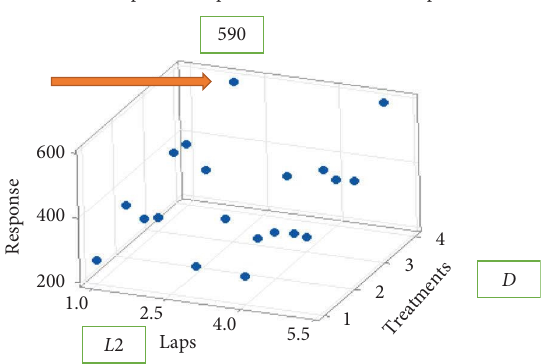
Figure 11: Second regular